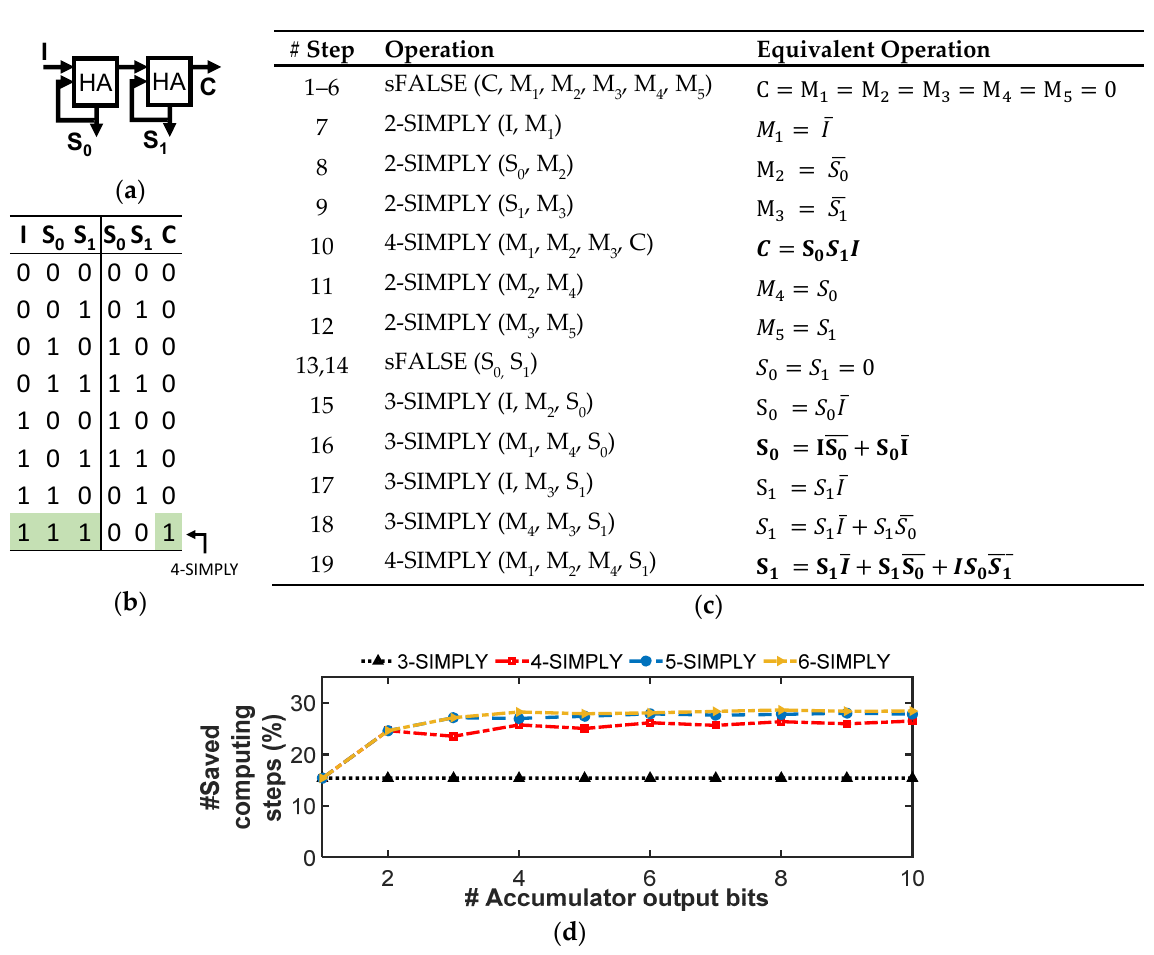
Figure 9. ( a ) Sequence of IMPLY and FALSE operations required for implementing the XNOR operation using n-SIMPLY. While 9 steps and 2 support devices are needed when using only 2-SIMPLY [30], the increased parallelism provided by n-SIMPLY reduces to 5 the number of computing steps, and only 1 support device is needed. ( b ) Circuit implementation of the XNOR operation on the SIMPLY architecture.